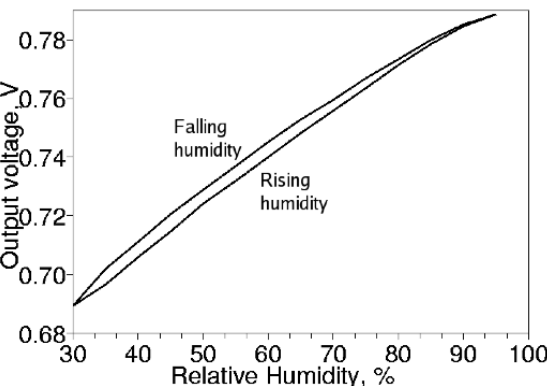
Figure 5. Hysteresis of humidity sensor at 25